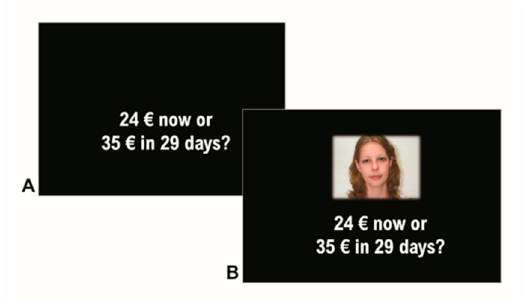
Figure 1. Behavioral Paradigm. Participants were asked to press the “A” key if they preferred the immediate reward in the MCQ and sure reward in the PDQ and to press the “L” key if they preferred the delayed reward in the MCQ and the probabilistic reward in the PDQ. Choice items were randomly presented in the baseline condition (proposer face was not shown) and in six face conditions as obtained by manipulating face gender (male, female) and face trustworthiness (trustworthy, neutral, untrustworthy). ( A ) Schematic representation of a trial in the baseline condition for the MCQ. ( B ) Schematic representation of the same trial in the “face” condition, with the picture of a proposer shown with the MCQ item.